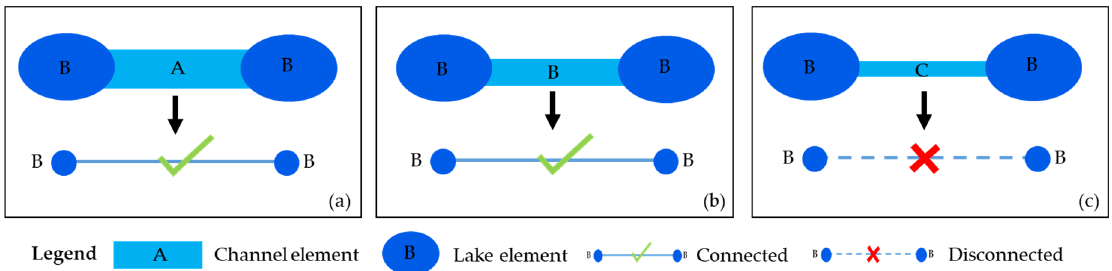
Figure 1. Judgment of the simple connected form. ( a – c ) represents simple connected forms of different grades. Grade A, B and C mean that the network elements (lakes and channels) are divided into different grades according to Table 1.